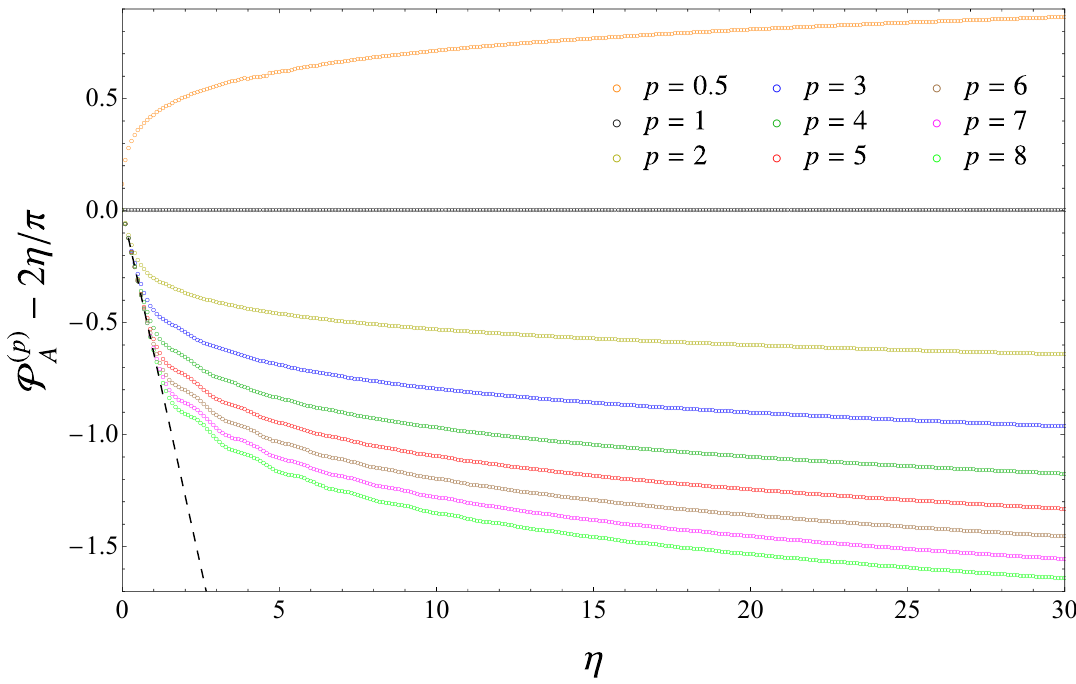
Figure 14. The p -th power of the Schatten p -norm of the sine kernel operator (see (9.1)) for some values of p > 0 , where the linear divergence (9.16) for large η has been subtracted to highlight the subleading correction (see (9.17)). The black dashed straight line is − 2 η/π